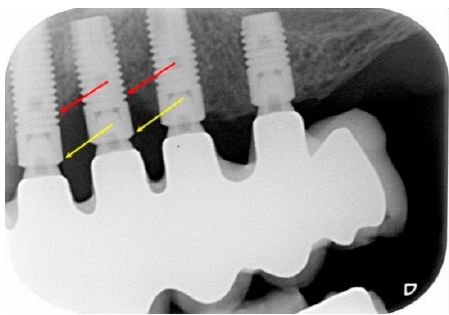
Figure 1. The yellow arrow points to the reference point (lower border of the smooth implant collar). The red arrow shows the first bone-to-implant contact. The distance in between was measured with digital